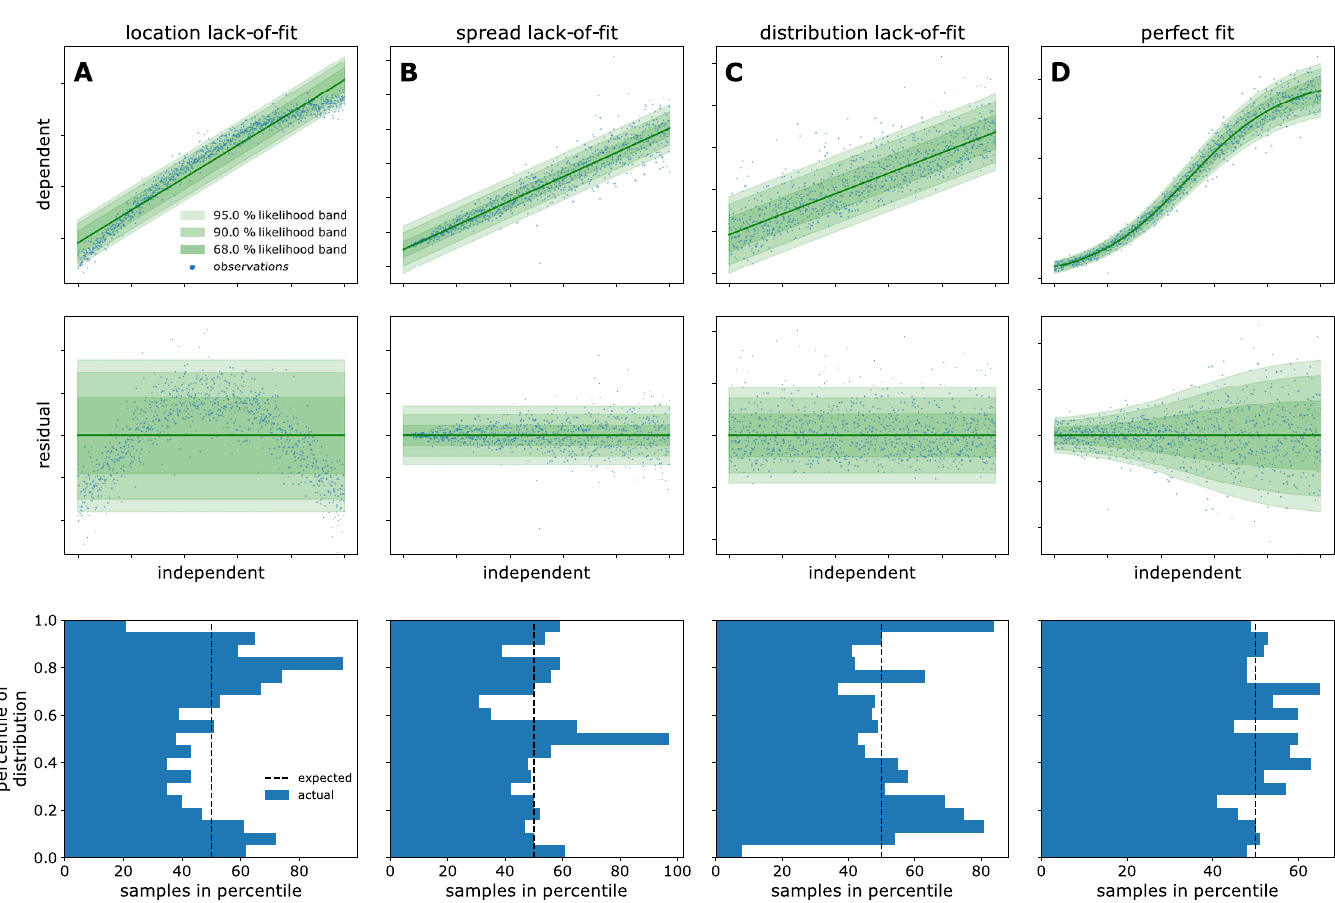
Fig 4. Uncertainty about the independent variable. An intuition for inferring the independent variable from an observed dependent variable is to cut (condition) the green probability distribution model at the observed value (blue slices) and normalize its area to 1. The resulting (blue) slice is a potentially asymmetric probability distribution that describes the likelihood of the observation, given the independent variable. Its maximum (the maximum likelihood estimate) is the value of the independent variable that best describes the observation. For multiple observations, the probability density function for the independent variable corresponds to the product of the PDFs of the observations. The red shoulders mark the regions outside of the 90% equal-tailed interval.